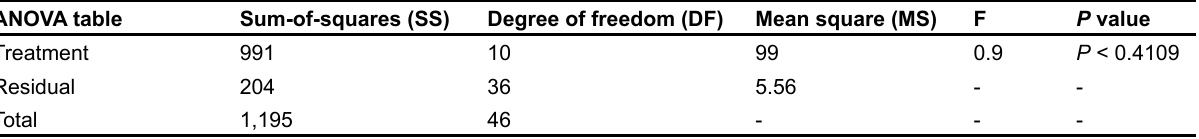
Table 2. Summary of ANOVA analysis on MDA-MB-231 cell line to assess the metabolism (MT) cell viability assay with all the treatments with low doses and voltages